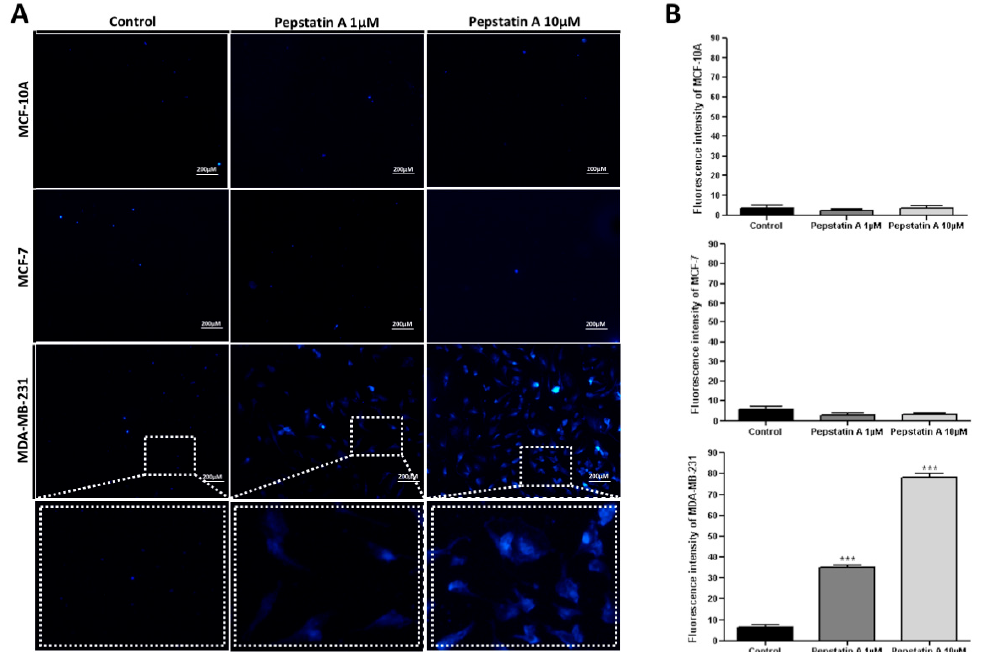
Figure 5. CatD inhibition promotes MDC-labeled autophagic vacuoles formation only in MDA-MB-231 cells. ( A ) Autophagic vacuoles (blue) in MCF-10A, MCF-7, and MDA-MB-231 cells stained with MDC after exposure to PepA (1 µ M and 10 µ M) for 24 h compared to control group (vehicle only). Dashed rectangle demonstrates the zoom view of each cell group. Scale bars = 200 µ m. ( B ) Histogram representing fluorescence intensity of MDC, determined by ImageJ software, in control and treated three cell lines. Data are expressed as the mean ± SD of three independent determinations, n = 15. Asterisks (*) indicate significant difference from control group (* p < 0.05; ** p < 0.01; *** p < 0.001). Comparisons between different groups were performed using one-way analysis of variance.